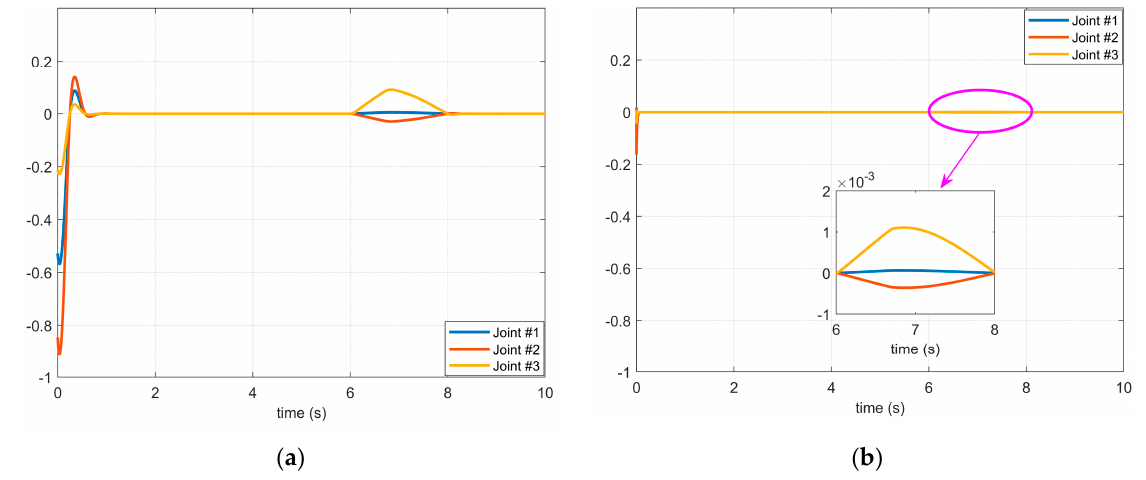
Figure 5. The effect of the 1st disturbance on the servo motor of each axis of the manipulator: ( a ) The BKS operator is not applied. ( b ) The BKS operator is applied.